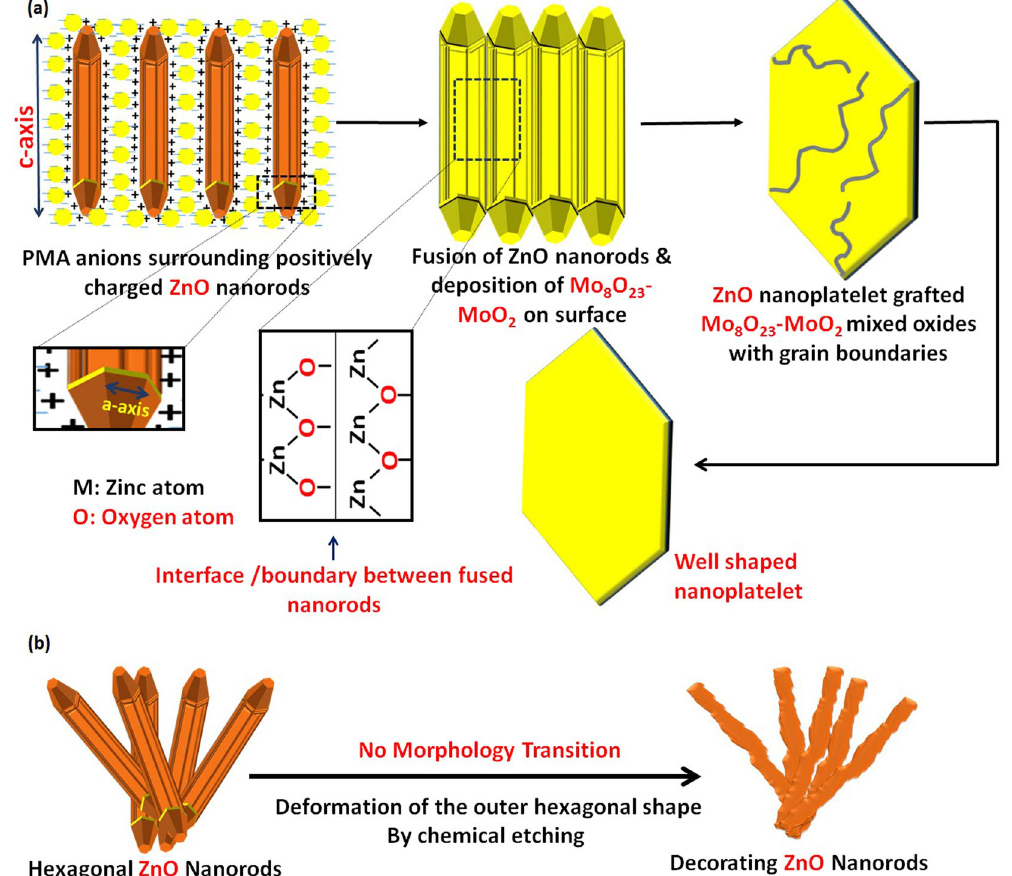
Figure 16. The proposed mechanism for the morphology transition (self-assembly) of hexagonal ZnO nanorods to ZnO nanoplatelets grafted Mo 8 O 23 -MoO 2 mixed